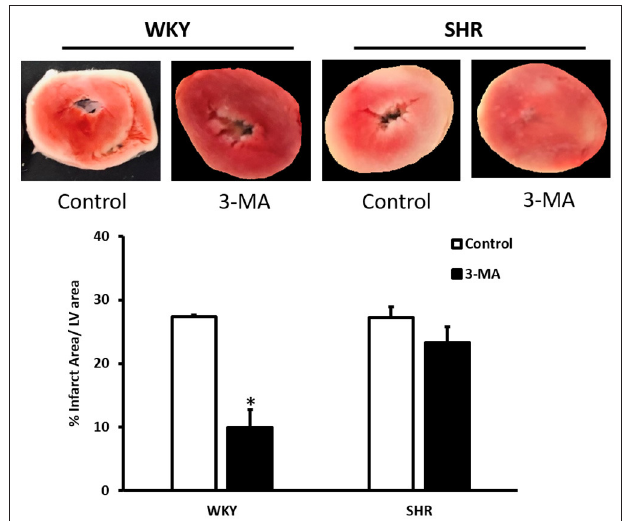
FIGURE 8 | Effect of 3-MA on infarct size in WKY and SHR. TTC staining of heart section from WKY and SHR treated with vehicle control or 3-MA 2h prior to sacrifice and subjected to I/R injury ex-vivo . Data are means ± SEM, * P < 0.001, n = 3–8 rats per